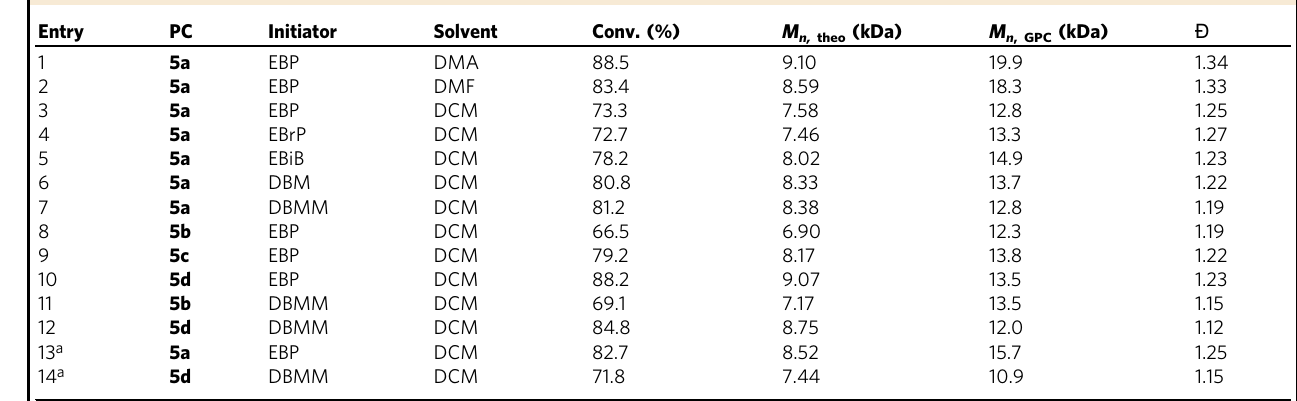
Table 1 Catalyst evaluation in the atom-transfer radical polymerization of